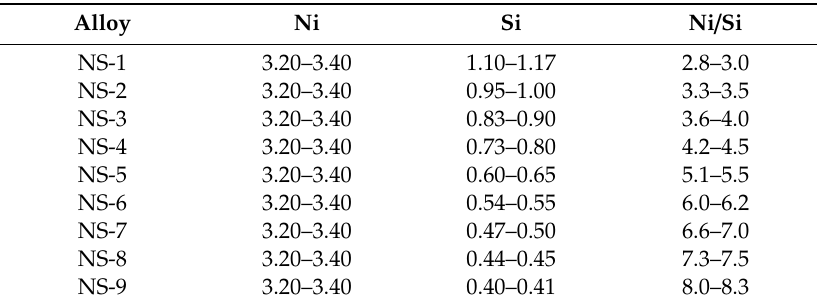
Table 1. Tested chemical compositions of Cu-Ni-Si alloys, wt %.